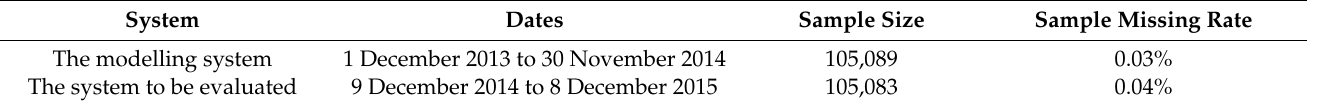
Table 2. Sample missing